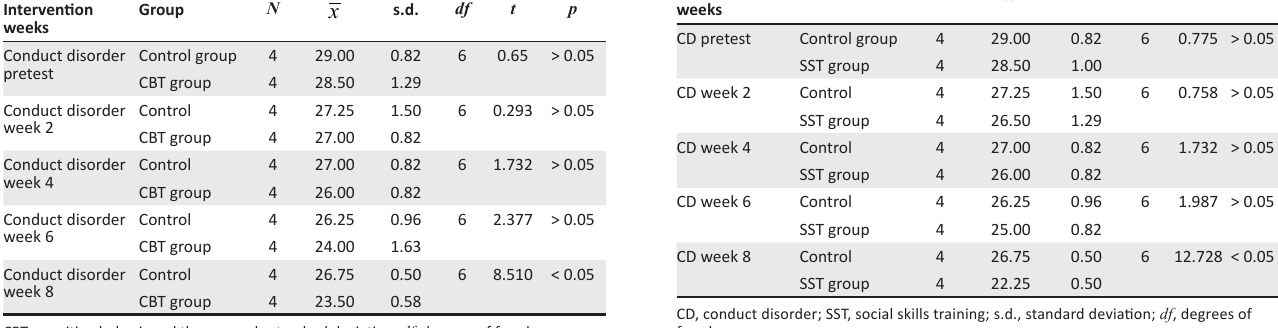
TABLE 2: Summary of t -test showing the significant difference in conduct disorder between the experimental group (social skills training) and control group. Intervention